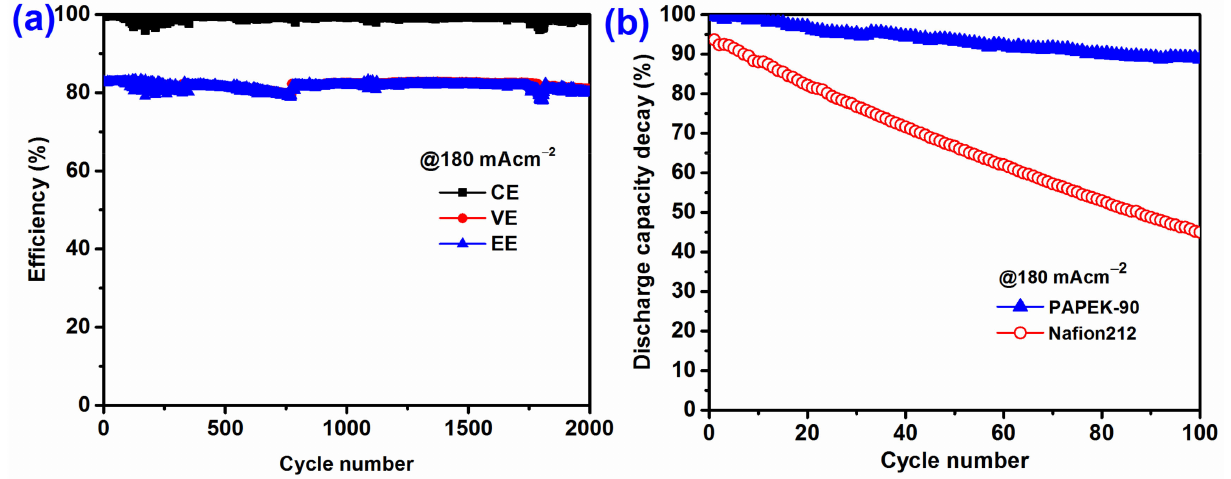
Figure 7. Cycling performance of VFB with PAPEK-90 membrane ( a ), the discharge capacity of the VFB with PAPEK-90 membrane ( b